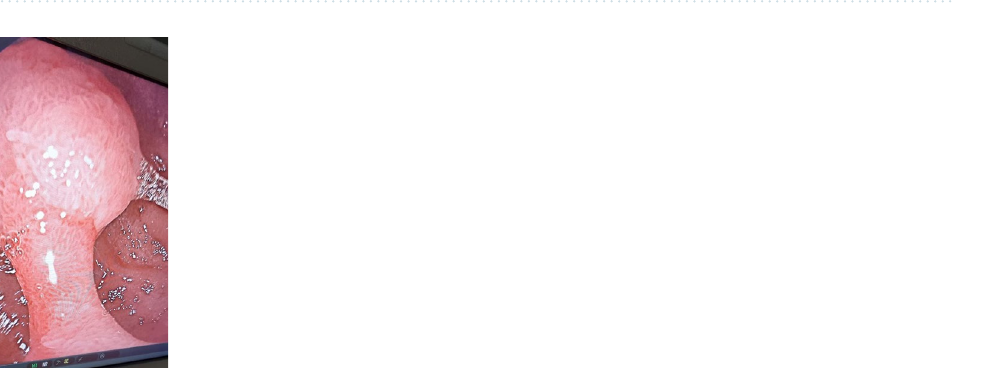
Figure 3. Duodenal adenomatous polyp